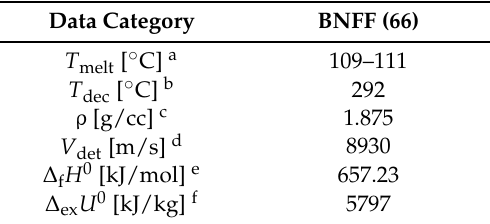
Table 9. Performance and sensitivities of BNFF.